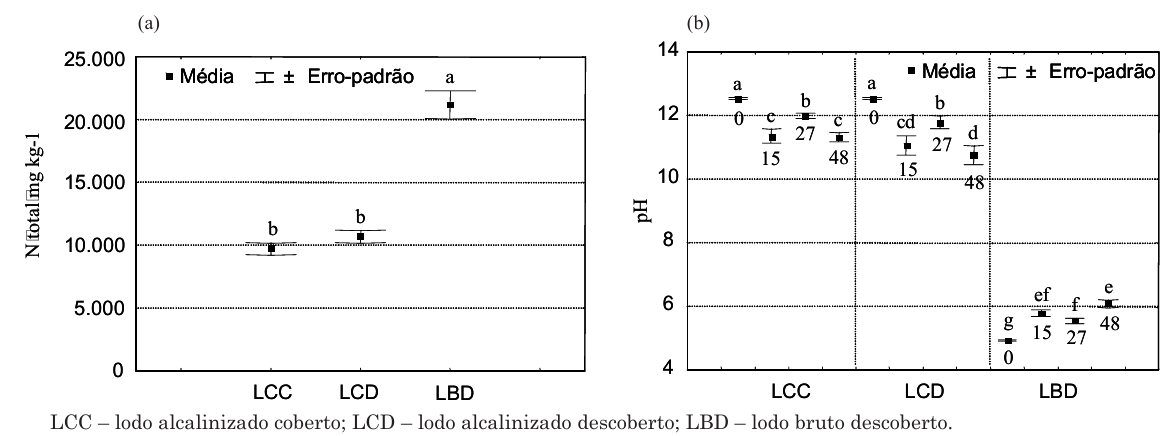
Figura 1. Teores médios de N total de acordo com o tipo de lodo (a) e valores de pH de acordo com o tipo de lodo e tempos de incubação de 0, 15, 27 e 48 dias (b).